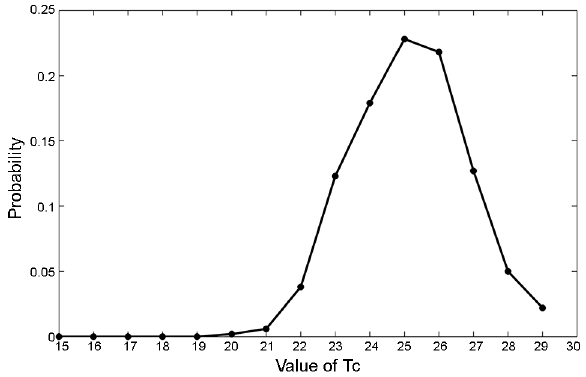
Figure 4. The probability of constant N corresponding to the minimum c T